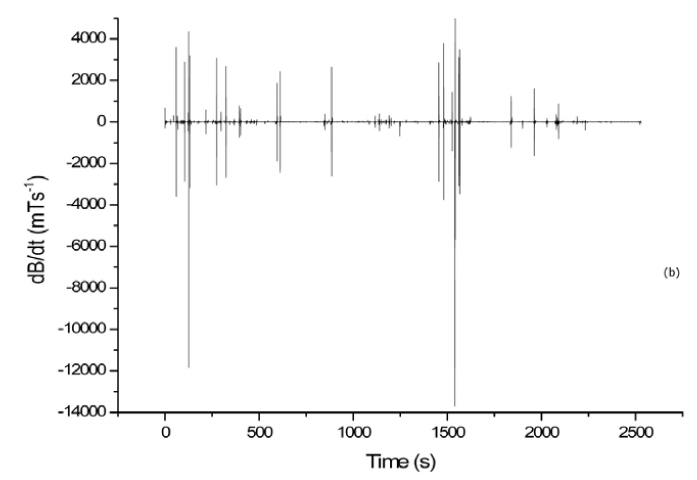
Figure 3. Measurement conducted in a 3.0 T site during cold head maintenance. ( a ) The worker exposure is reported and ( b ) the corresponding time-varying exposure is shown.